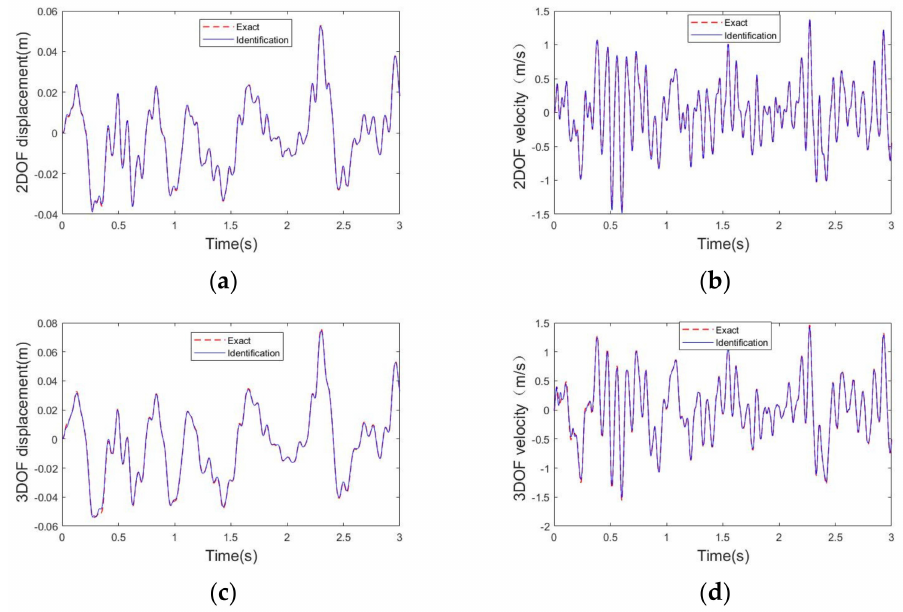
Figure 2. Comparisons of the exact and identified displacements and velocities. ( a ) Comparison of the exact and identified; ( b ) comparison of the exact and identified; ( c ) comparison of the exact and identified; ( d ) comparison of the exact and